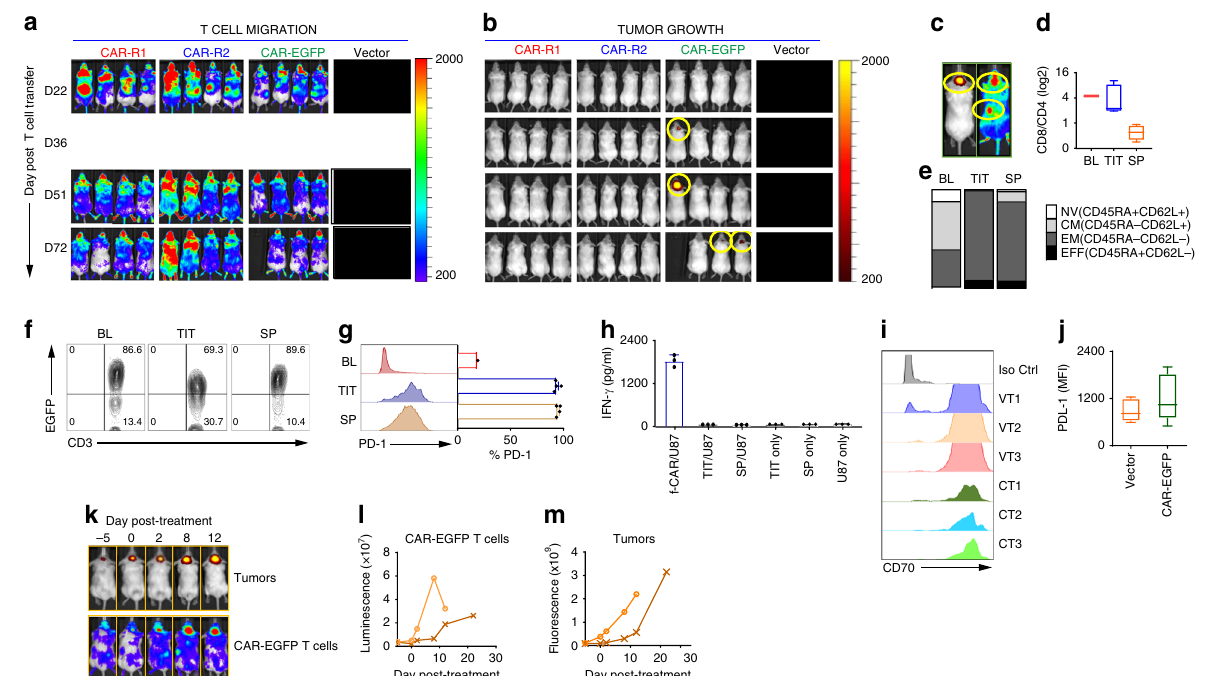
Fig. 5 un-mod-70CAR T-cell exhaustion at the time of tumor relapse. a , b T-cell persistence and tumor progression after the CAR T-cell transfer. Images of CAR T-cell and tumor growth were taken after cell transfer. Tumor signals were undetectable on day 22 in all CAR T cell-treated groups shown in Fig. 3; tumor relapses were observed from day 36 only in CAR-EGFP T cell-treated mice. c Representative images of the tumor (left) and CAR T cells (right) at the endpoint of a relapsed mouse. Tumors and spleens from these mice were harvested and analyzed by fl ow cytometry. d , e CD8/CD4 ratio, [Naïve (NV), Central Memory (CM), Effector Memory (EM), Effector (EFF)] of the tumor-in fi ltrating T cells (TIT, n = 4) and spleen (SP, n = 4), compared to before adoptive transfer (baseline, BL). The human CD3 + T cells were gated. f CAR T-cell persistence post CAR T cell transfer. The CAR T cells in BL, TIT and SP were determined. The data are representative of three mice. g PD-1 expression on CD3 + T cells in BL, TIT, and SP (mean ± SD, n = 4). h Tumor recognition of the TIT and SP cells isolated from the relapsed mice when they reached the endpoint. Fresh U87 tumors (1 × 10 5 ) were used as the target, and fresh- made CAR-EGFP (f-CAR) T cells were used as a positive control. IFN- γ release assay was carried out 18 hrs after the coculture (means ± SD). i , j Expressions of CD70 and PD-L1 on relapsed tumors. The relapsed mice ( n = 3) from the CAR-EGFP-treated (CT) and vector T cell-treated (VT) group were evaluated for CD70 and PD-L1 expressions by fl ow cytometric analysis. k Representative images of tumor progression and CAR T-cell persistence in the ROI are displayed. i – m The relapsed mice ( n = 2) were re-administered the fresh-made CAR-EGFP T cells by i.v. (2 × 10 6 /mouse) without IR, and the CAR T cells and tumor growth were monitored and evaluated in these mice. The boxplots represent the mean and minimum-to-maximum